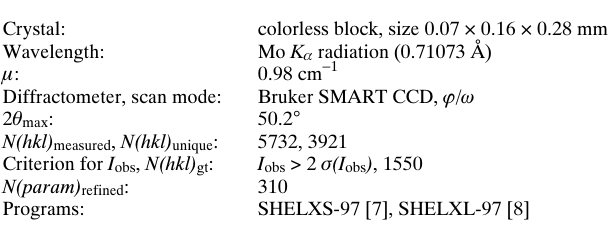
Table 1. Datacollection and handling.